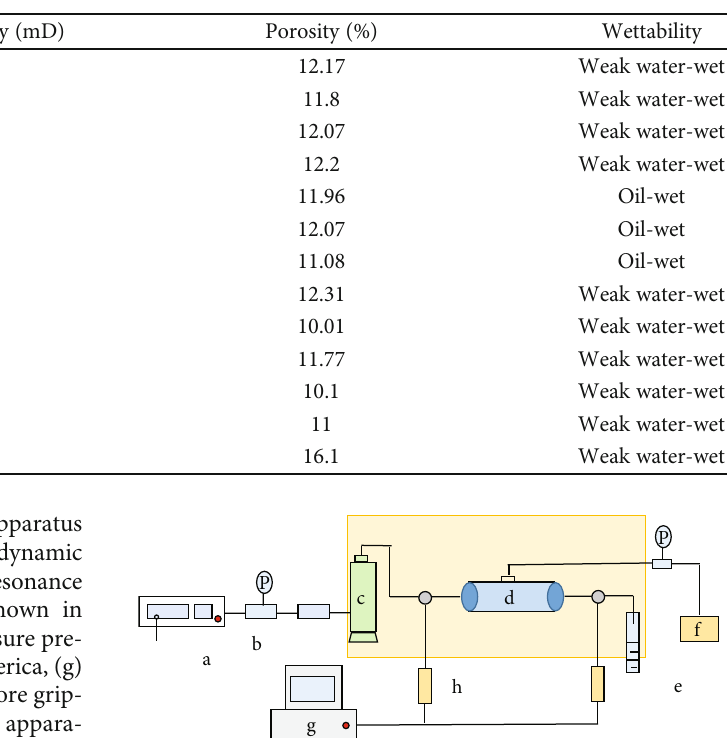
Table 1: Basic parameters of testing cores.